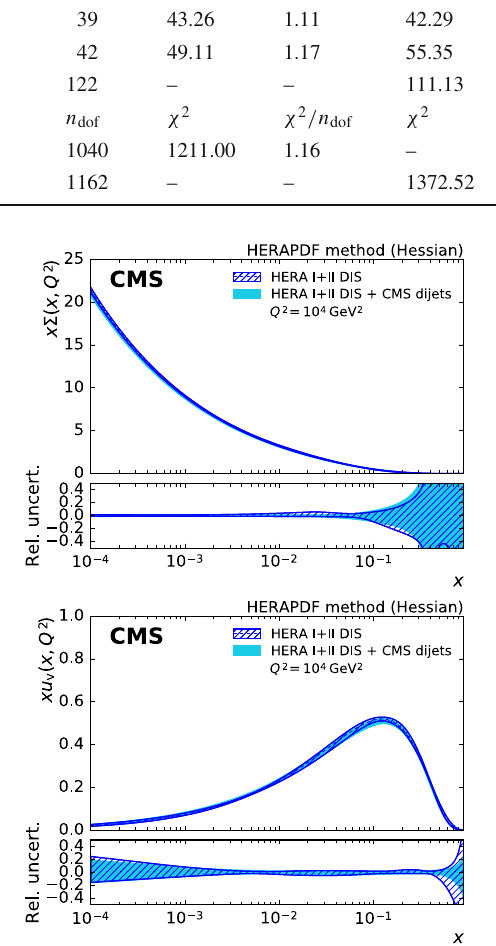
Table 2 The partial χ 2 ( χ 2 p ) for each data set in the HERA DIS (middle section) or the combined fit including the CMS triple-differential dijet data (right section) are shown. The bottom two lines show the total χ 2 and χ 2 / n dof . The difference